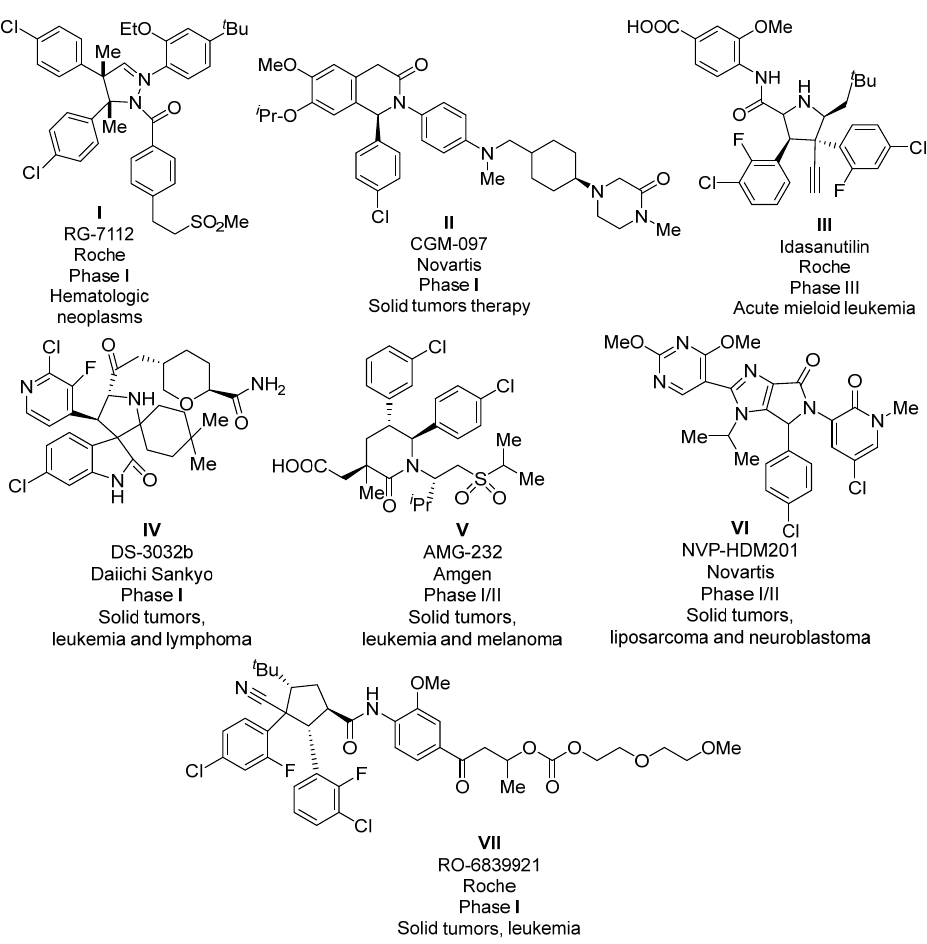
Figure 1. Small-molecule MDM2 inhibitors investigated in different clinical trials.